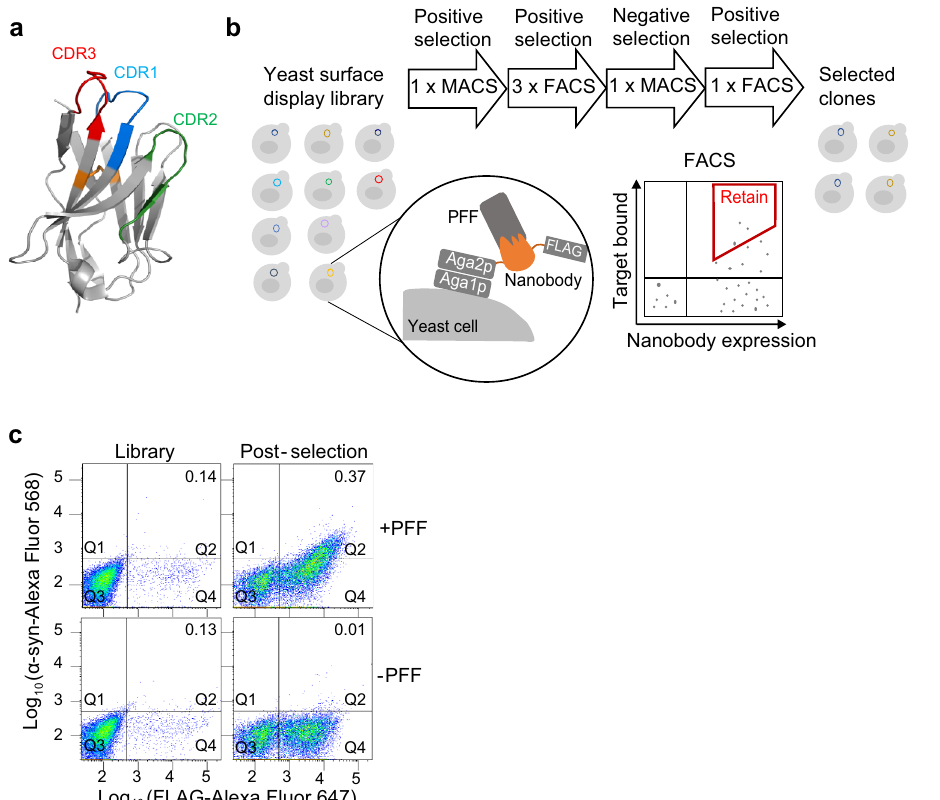
Fig. 1 Nanobody selection against α -syn PFF. a Nanobody crystal structure (based on PDB: 4LDE). Conserved disul fi de bond (orange) was removed in our libraries. b Nanobody selection schematics. Nanobodies were expressed on the yeast surface by fusion to the C-terminus of Aga2p protein, followed by the FLAG tag. Yeast cells that bind to α -syn PFF were selected using MACS and FACS. Red trapezoid, a representative selection gate. c FACS analysis of nanobody libraries before and after selection. After 6 rounds of selection, the selected nanobodies showed a higher PFF-binding signal, compared to the original libraries and negative control (without α -syn PFF). The numbers in the upper right Q2 indicate the yeast population ratio of